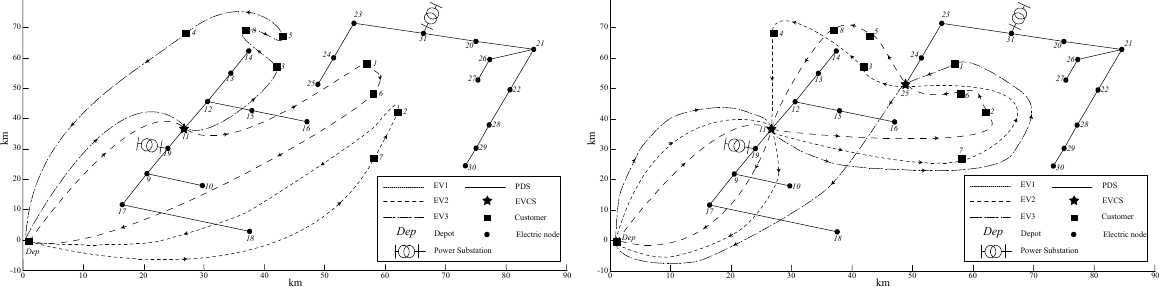
Fig. 12. Pn8k3-DS23N with M =2 and Q =160 km Fig. 13. Pn8k3-DS23N with M =150 and Q =60